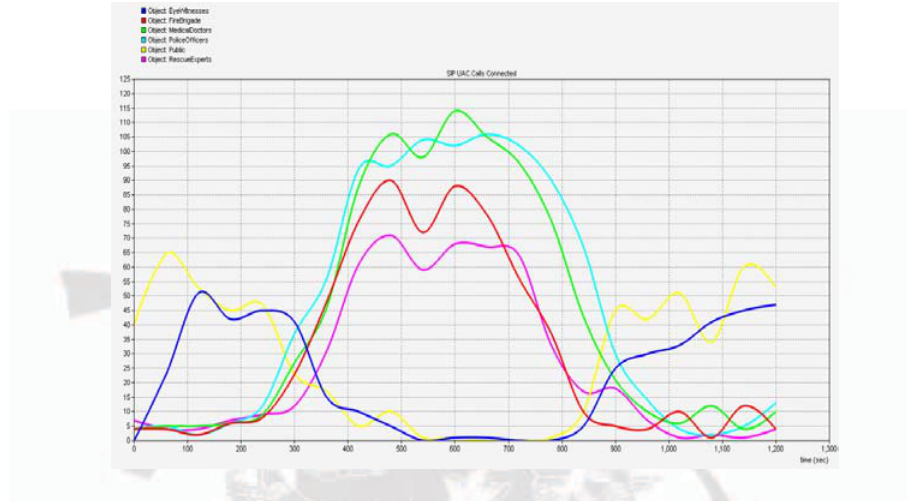
FIGURE 14: CONNECTED CALLS AS OBSERVED AT EACH SIP CLIENT